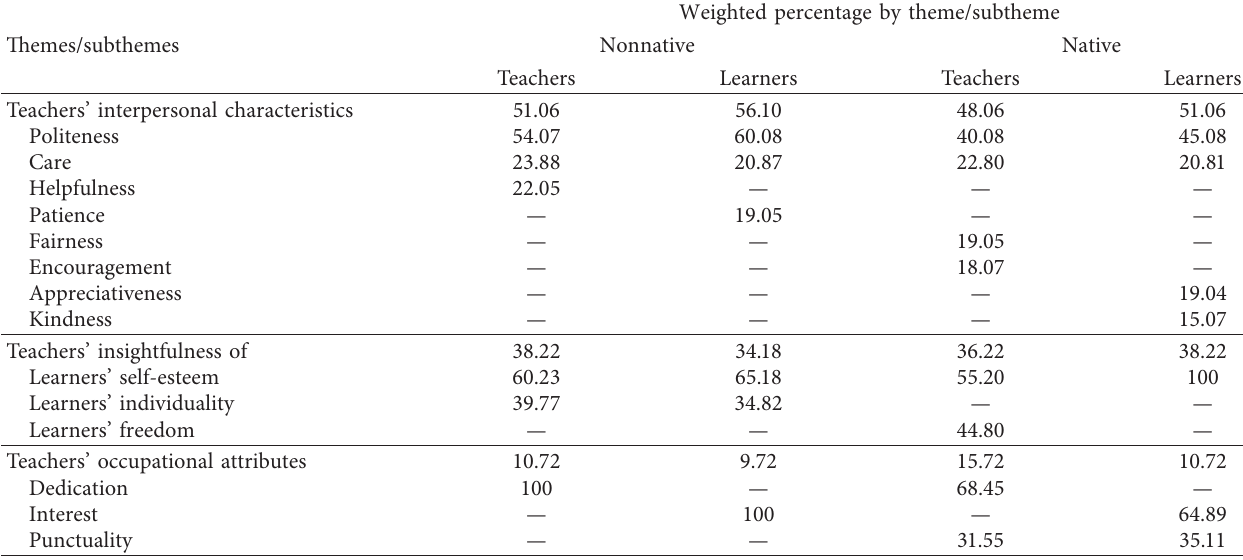
Table 4: Themes and subthemes pertaining to participants’ perceptions of teachers’